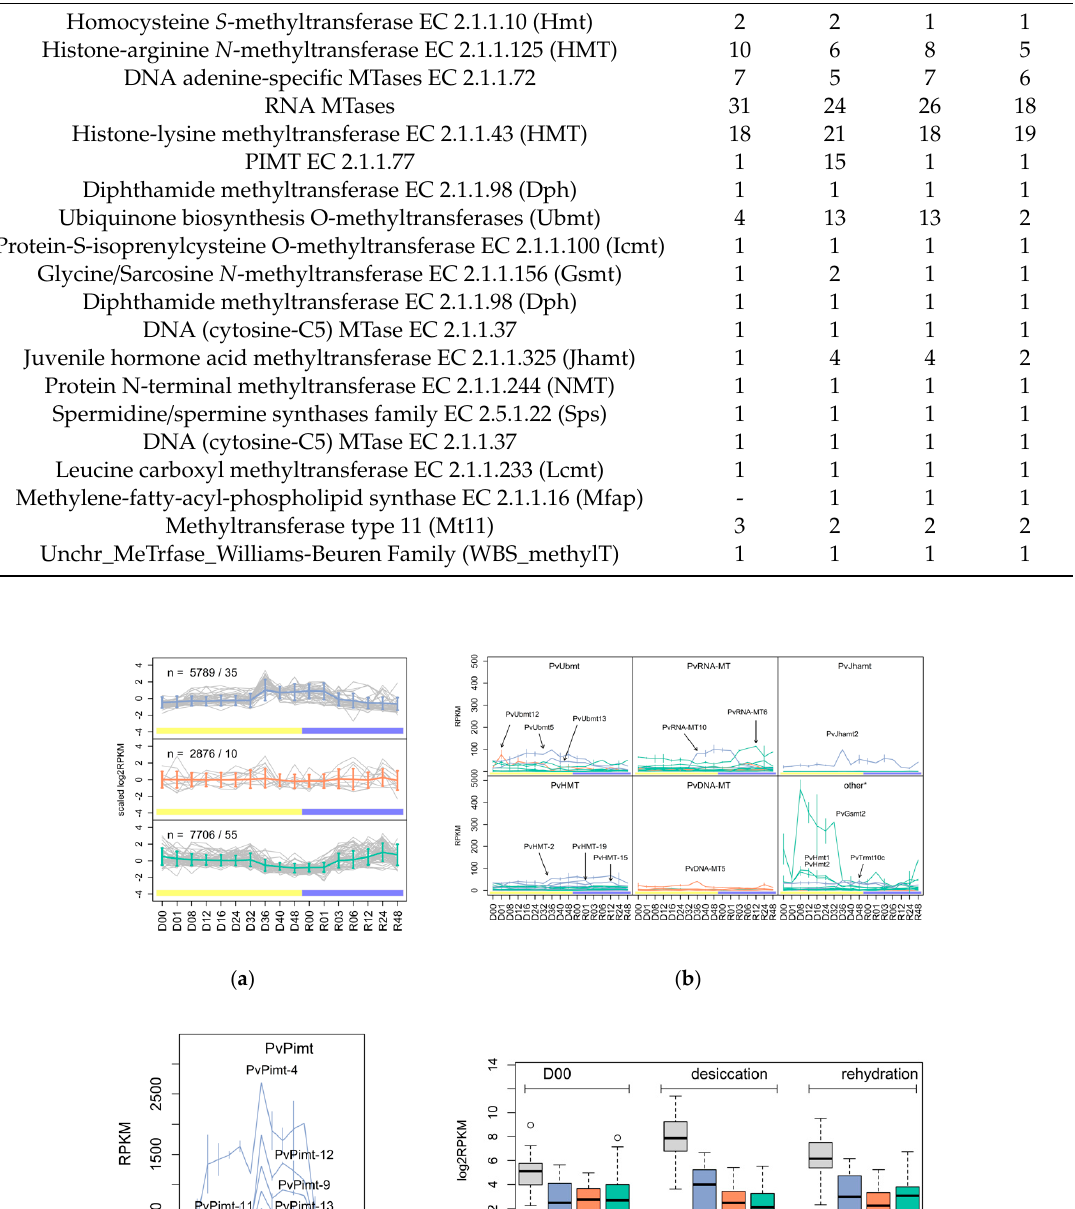
Table 1. Discovered S-adenosyl-l-methionine (SAM) dependent MTases in D. melanogaster (D. mel ) and chironomid species: P. vanderplanki ( P. van ), P. nubifer ( P. nub ), and B. antarctica ( B. ant ). Insect Species